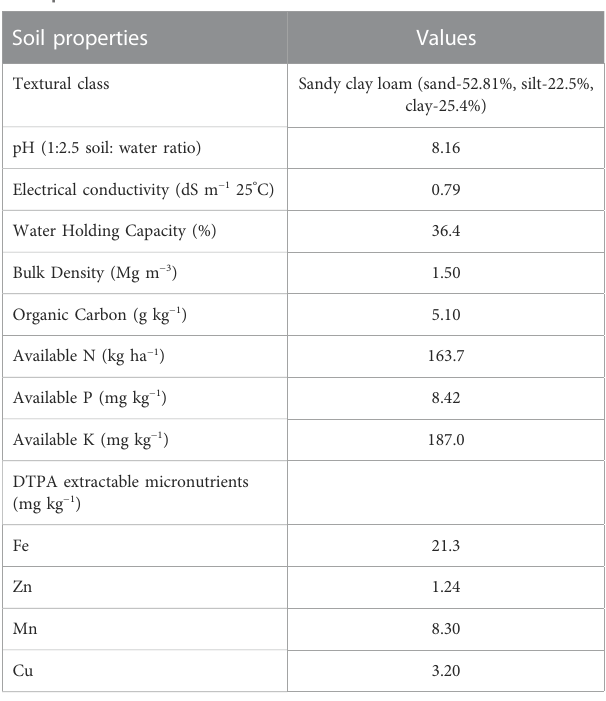
TABLE 1 Different physicochemical properties of the soil before commencing the